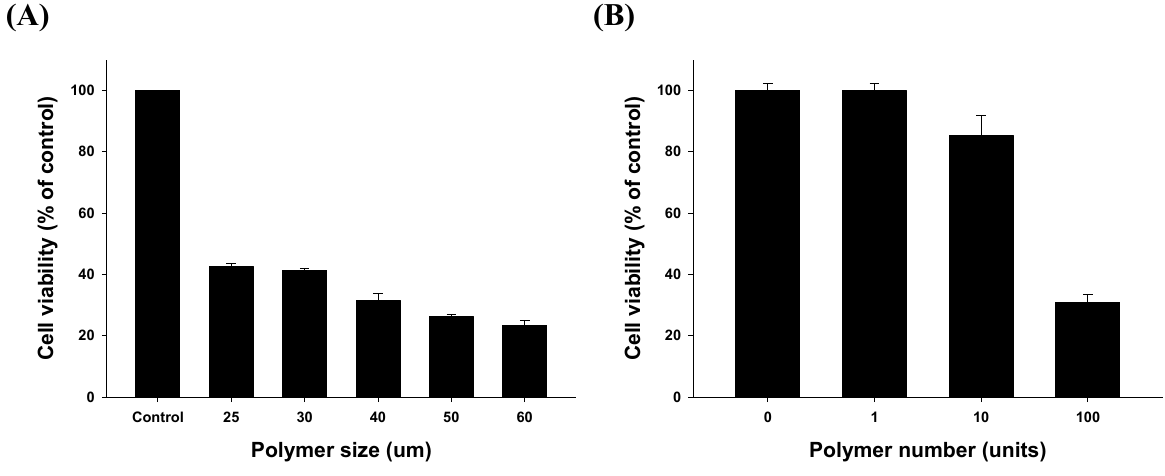
Figure 5. Evaluation of size- and dose-related drug release efficiency ( A ) Cell growth inhibitory activity of various sized (25, 30, 40, 50 and 60 μm) microstructures was evaluated with MTT assays. Each test group was treated with the same number of units (100 units) and same treatment time (72 h); ( B ) Fixed size (40 μm) and varying numbers of units (1, 10 and 100 units) tested over 72